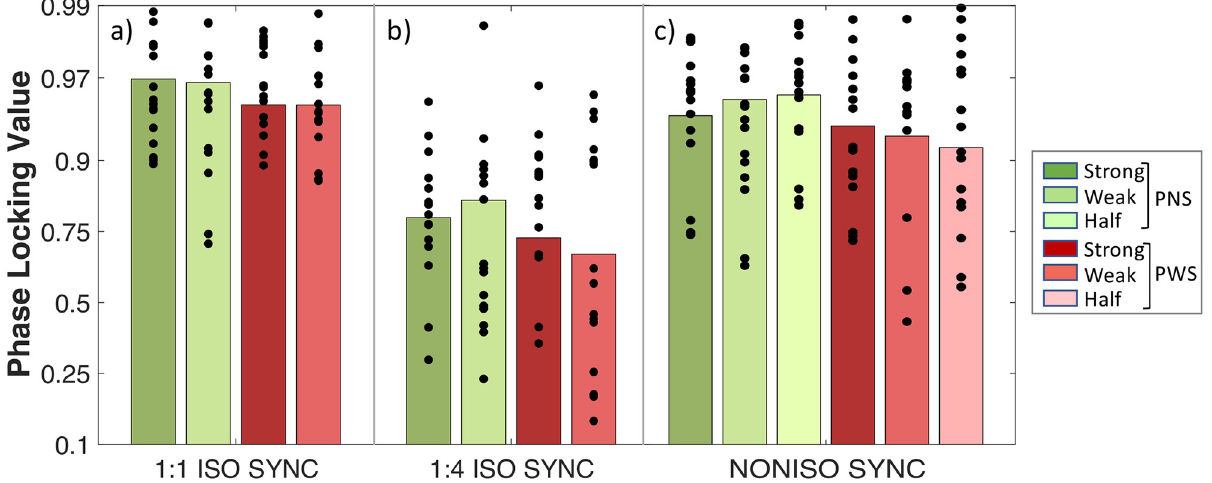
Fig 7. Phase Locking Value on the “strong” vs. “weak” beats of a 8-beat isochronous pattern, in which all the beats were marked by an auditory stiumulus (1:1_ISO_SYNC), or only the strong ones (1:4_ISO_SYNC), and on the “half-beat” pulses of a non-isochronous pattern (NONISO_SYNC). People who stutter (PWS, N = 16) are compared to with matched control particpants without speech disorders (PNS, N = 16).